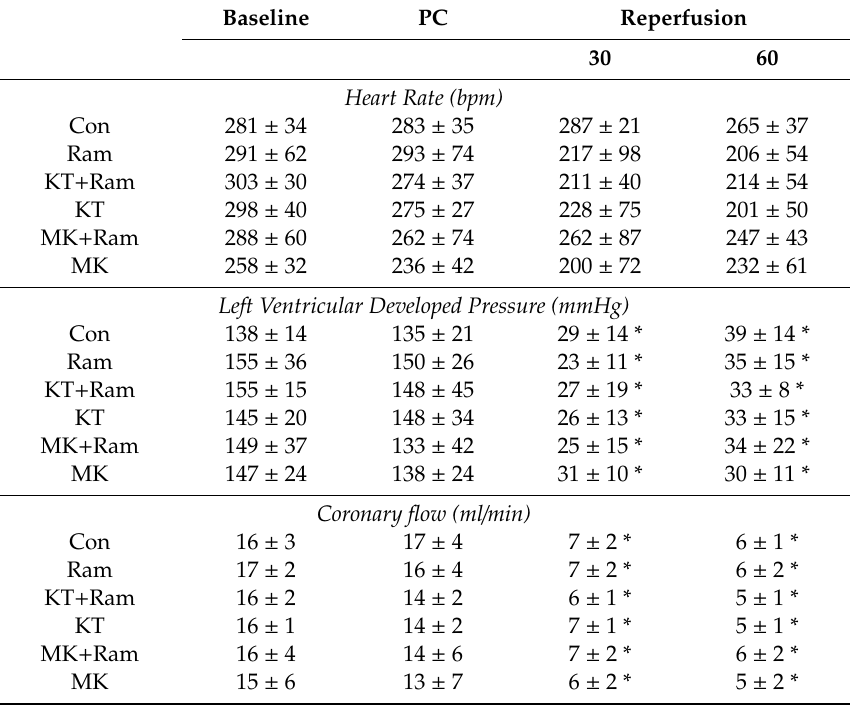
Table 2. Hemodynamic variables.